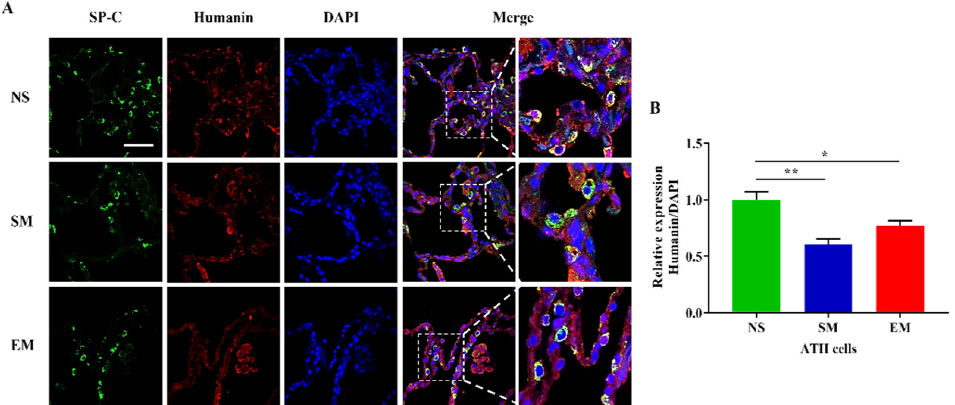
Figure 5. Humanin expression in ATII cells. ( A ) Lung sections were obtained from nonsmokers (NS), smokers (SM), and emphysema (EM). Staining using SP-C (green) and humanin (red) antibodies and DAPI (blue) was performed by immunofluorescence using confocal fluorescence microscopy. ( B ) Relative humanin protein expression was normalized to DAPI intensity in ATII cells identified using SP-C staining. Data are presented as means ± s.e.m (N = 4–14 per group; * p < 0.05; ** p < 0.01, scale bar, 50 μ m).